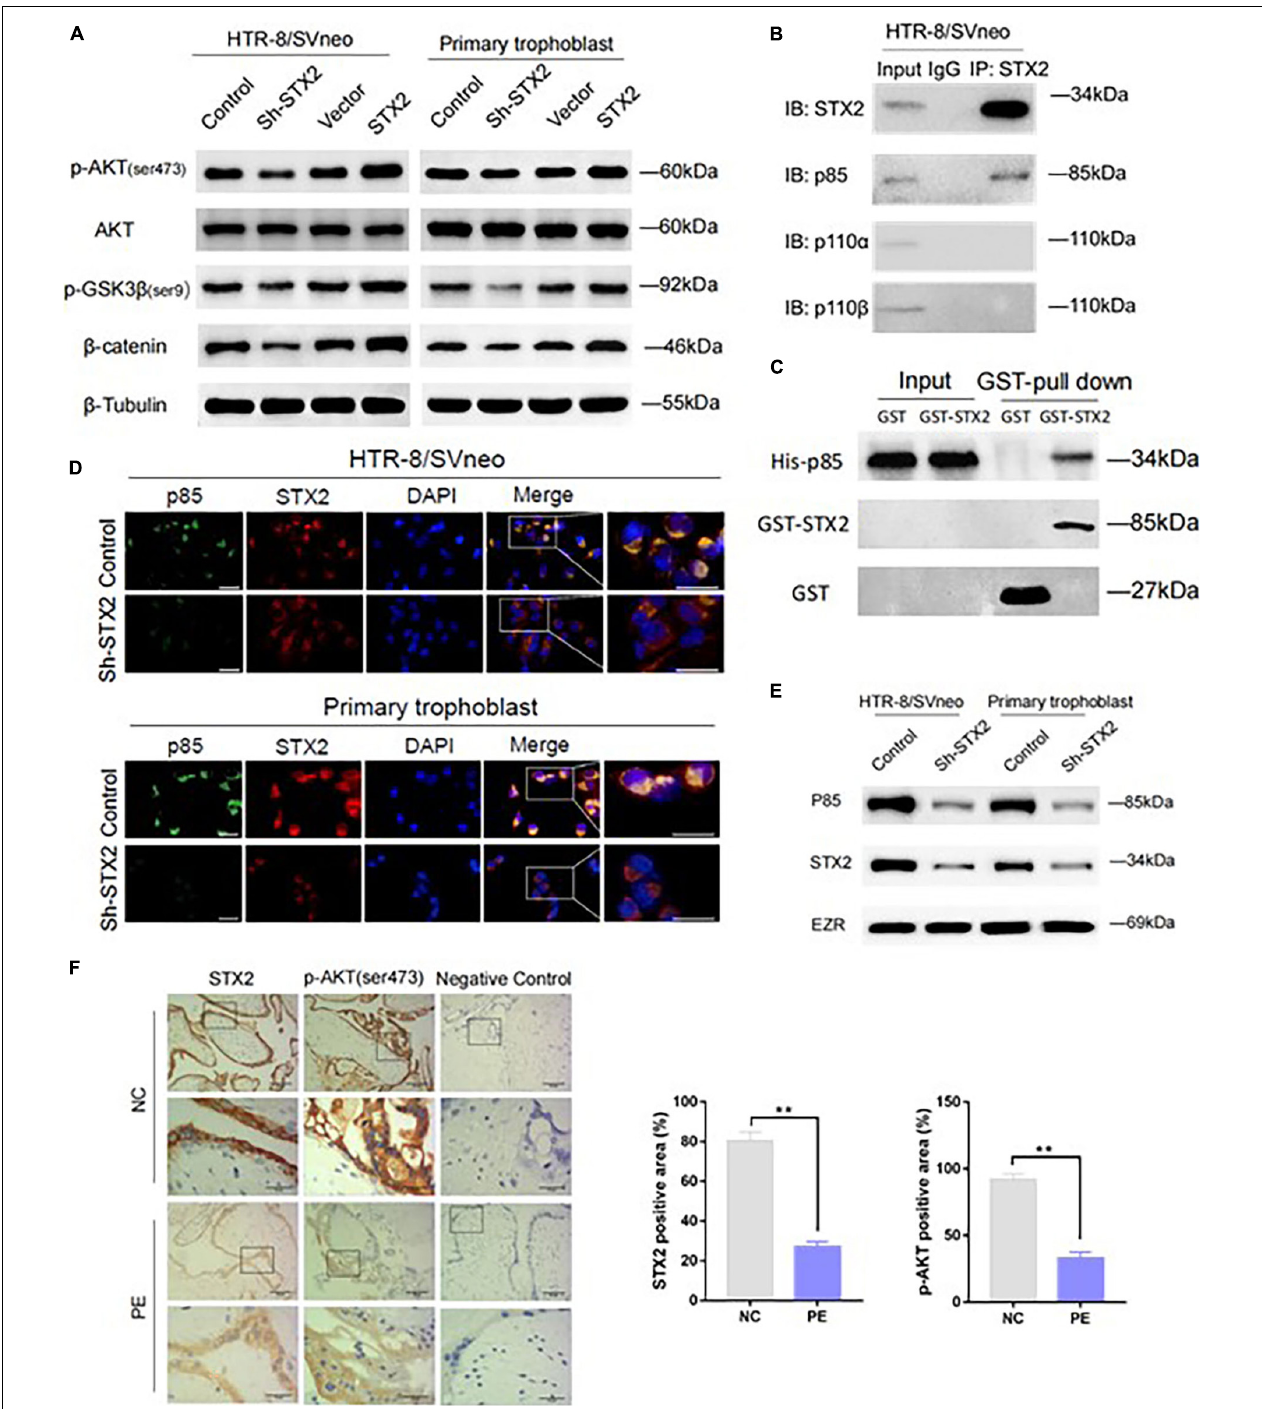
FIGURE 3 | STX2 activates the AKT signaling pathway via membrane recruitment of PI3K p85. (A) Western blot analysis of p-AKT (ser473), AKT, p-GSK3 β (ser9), and β -catenin in stably transfected HTR-8/SVneo and primary human trophoblast cells. β -Tubulin was used for normalization. (B) Co-IP results showing cell lysates were immunoprecipitated (IP) with antibodies for STX2, followed by western blot using PI3K p85, PI3K p110 α , PI3K p110 β , or STX2 antibodies. (C) GST pull-down assay was performed to clarify the binding between STX2 and PI3K p85 in vitro . (D) Confocal microscopy detection of subcellular distribution of STX2 (red) and PI3K p85 (green) in HTR-8/SVneo and primary human trophoblast cells transfected with Sh-STX2. Scale bar: 25 µ m. (E) Western blot analysis of the expression of p85 in membrane protein of control and experimental cells in which STX2 was knocked down. (F) Representative images of IHC staining for STX2 and p-AKT (ser473) in patients with PE ( n = 4/group). Data are represented as the mean ± SEM. Student’s t -test: ** P < 0.01. All the experiments were repeated three times independently.